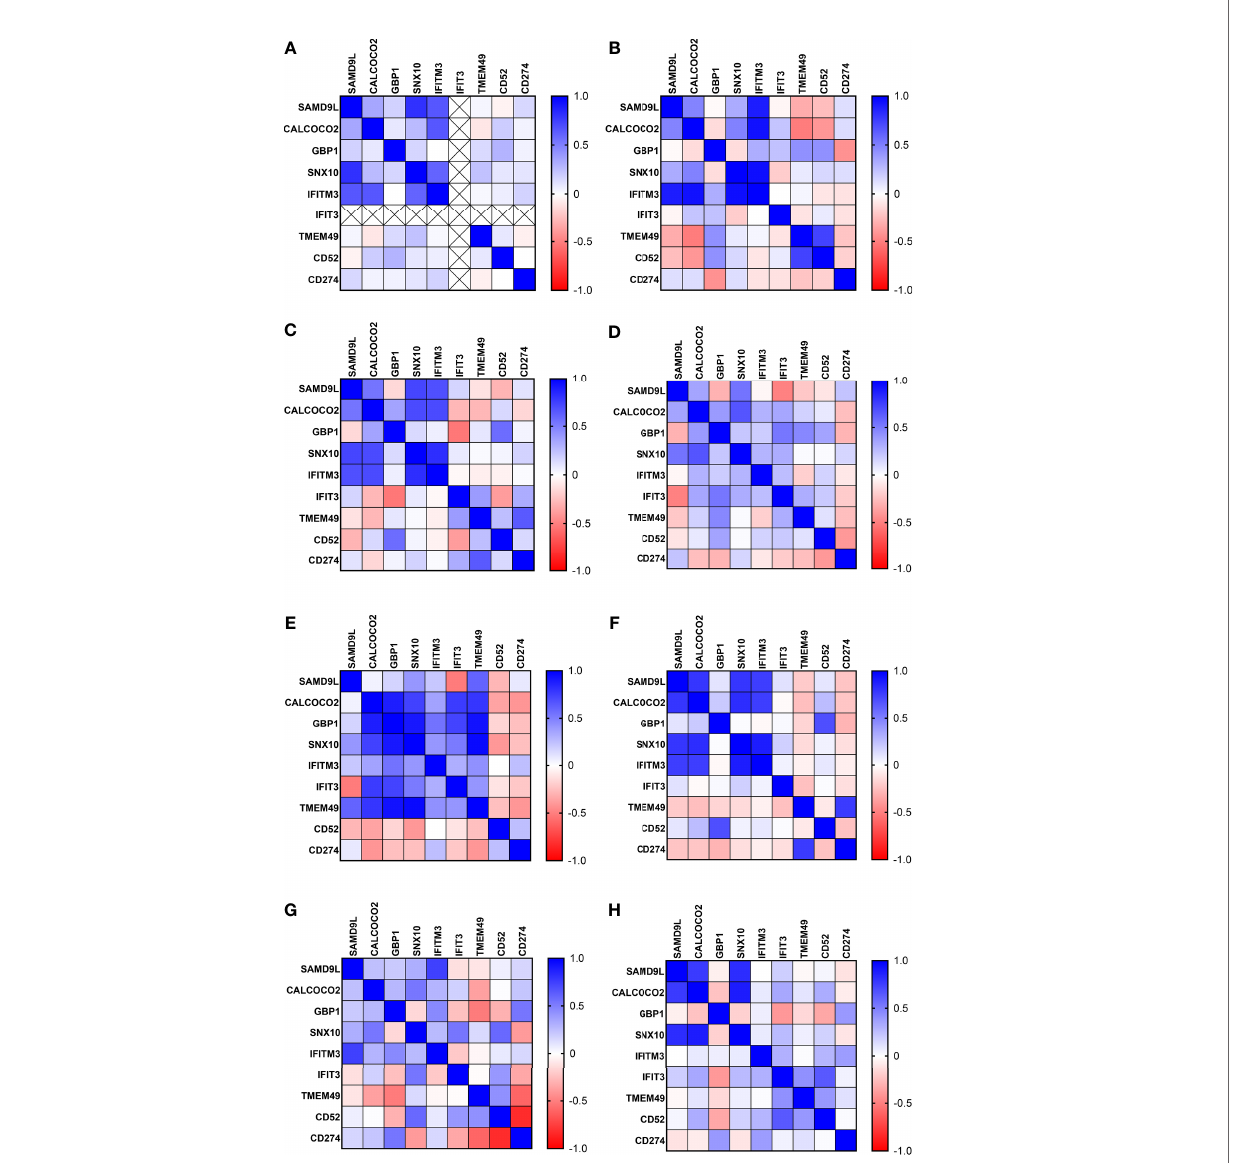
FIGURE 3 | Correlation matrix analysis of protein biomarker inter-relationships in all control and TB disease groups (A) UK-CNTRL (B) P-CNTRL (C) A-CNTRL (D) LTBI non-progressors (E) LTBI progressors (F) J-EPTB (G) A-EPTB (H)